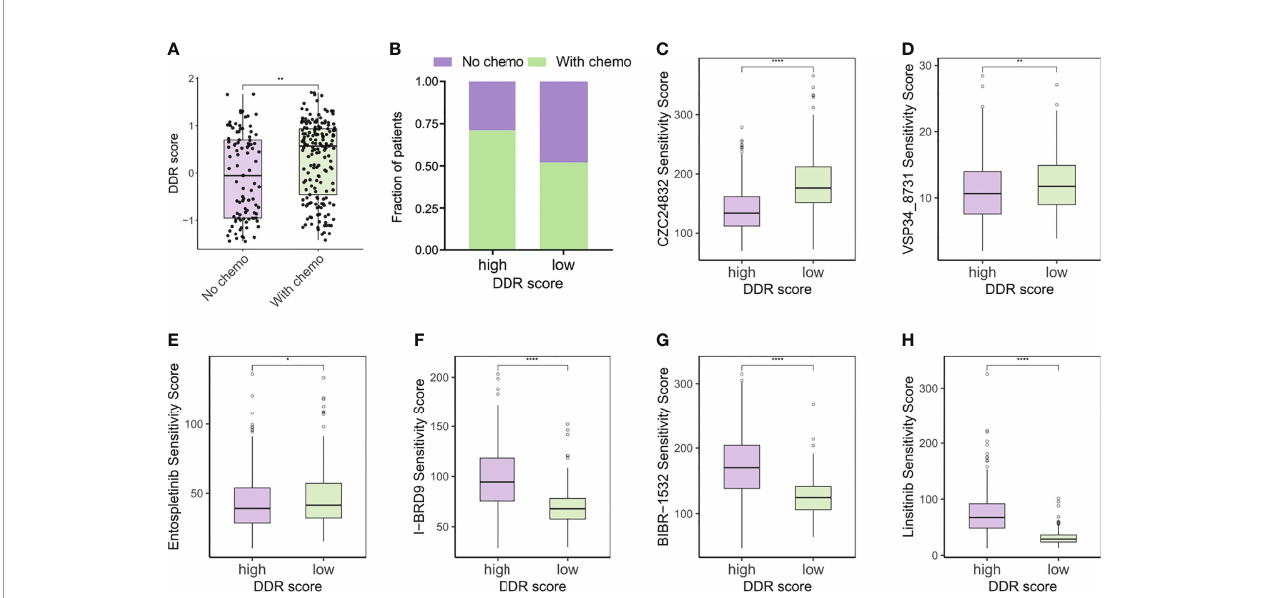
FIGURE 8 | DDR score subtypes guided chemotherapy strategies. (A) The DDR scores of patients with or without chemotherapy. (B) Rate of chemotherapy statuses (No/With chemo) in high and low DDR score groups. (C – E) Predicted sensitivity scores of CZC24832, VSP34_8731, and Entospletinib, which were candidate chemotherapeutic agents for high DDR score patients. (F – H) Predicted sensitivity scores of I-BRD9, BIBR-1532, and Linsitinib, which were candidate potent drug options for low DDR score patients. *p < 0.05; **p < 0.01; ****p <